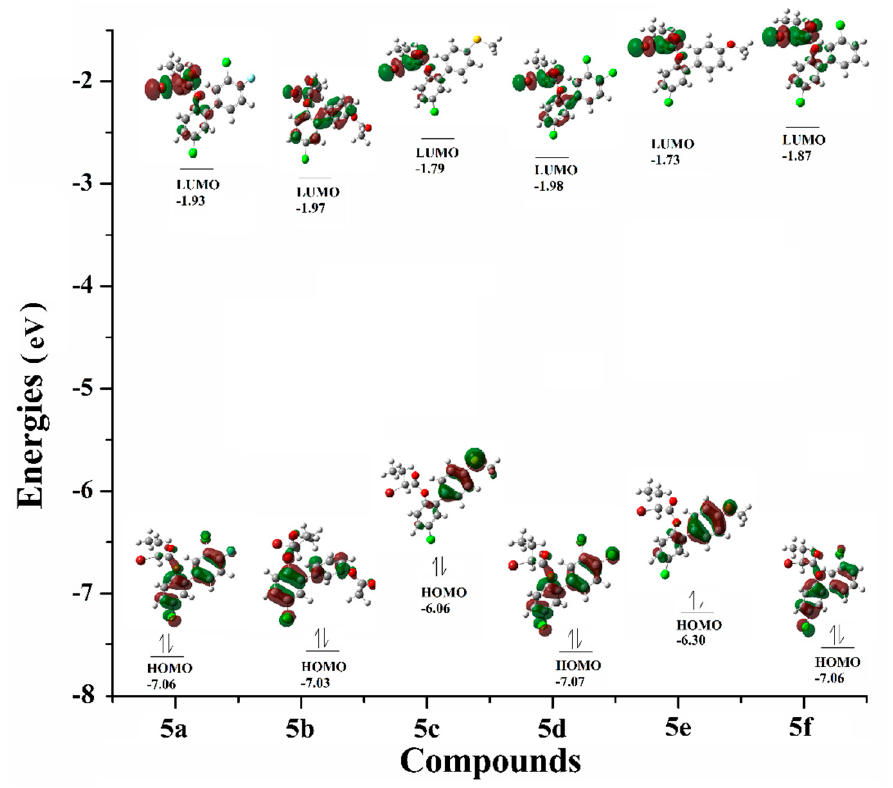
Figure 1. FMOs plot of all compounds ( 5a – f ) based on the relative energies; the energies are in eV.